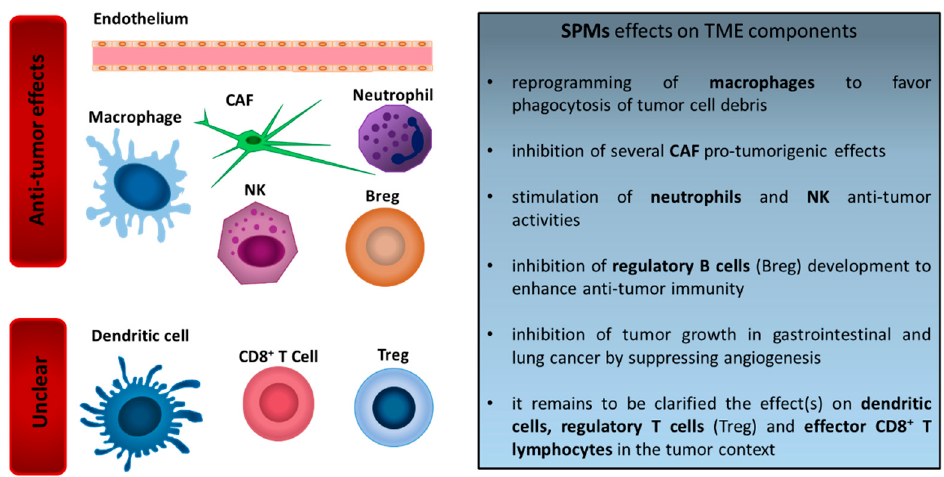
Figure 1. Effect of SPMs on TME components.